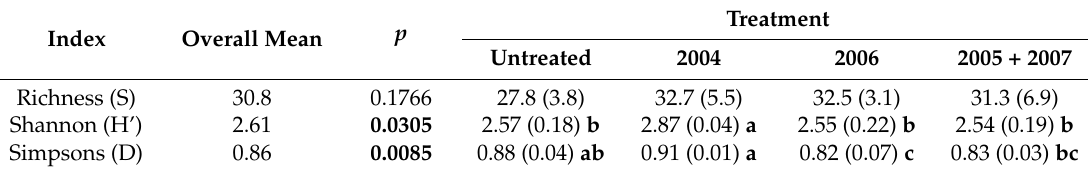
Table 2. Effects of treatments on plant community diversity index values at age 11. Standard deviation is shown in brackets () beside each mean. Where Analysis of Variance indicates significant treatment effects ( p < 0.10) (indicated in bold), letters are used to indicate differences between treatments determined using Tukey’s HSD test.